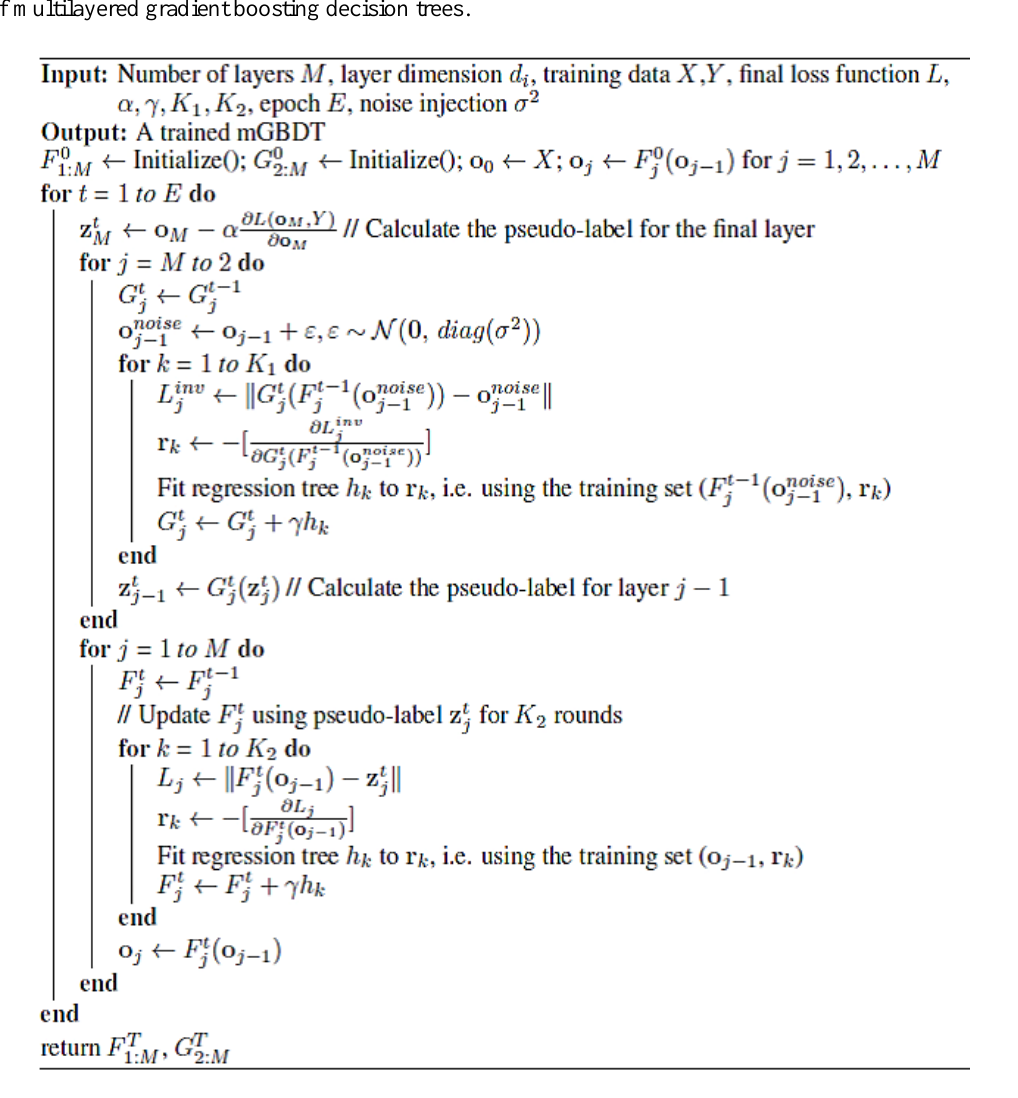
Figure 2. Multilayered GBDT